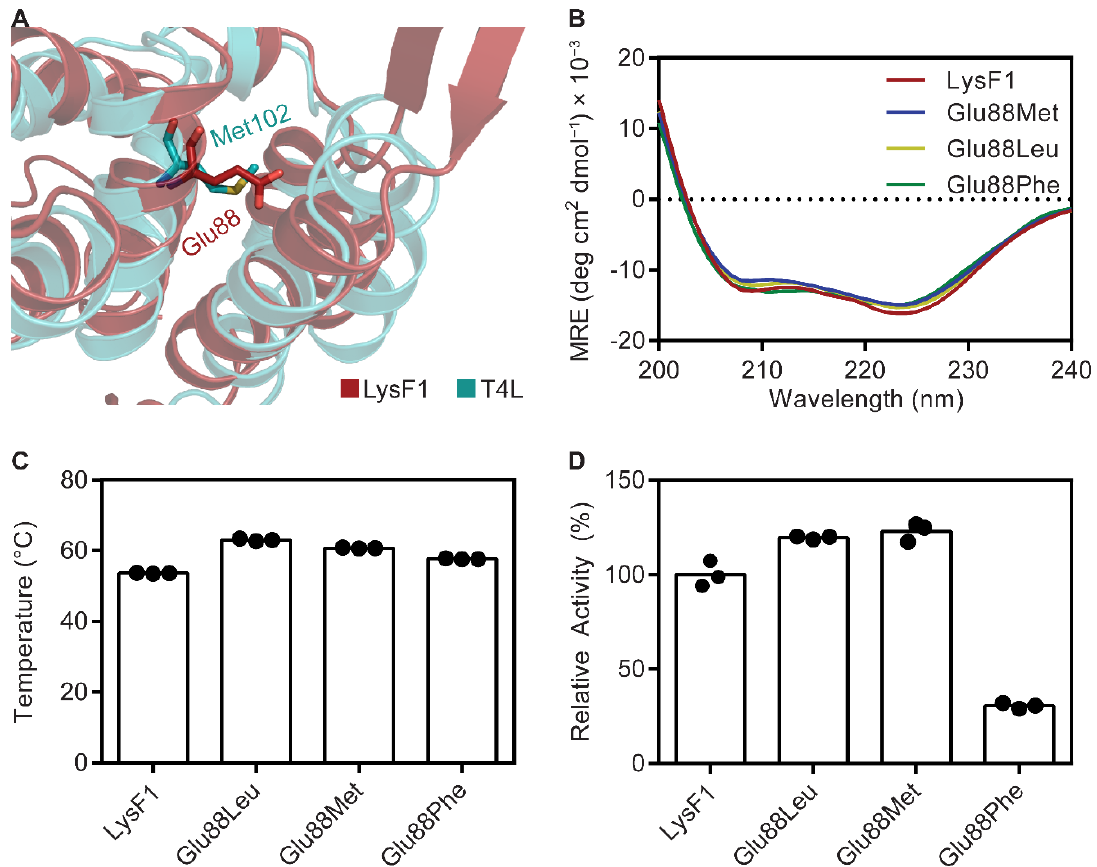
Figure 7. Thermal stability and relative activity of mutants of the charged core. ( A ) A magnified view of the C-terminal α-helix bundle with the crystal structures of LysF1 (red) overlaid with T4L (teal) and the residue of interest, Glu88 of LysF1, is displayed as a stick representation. The similarly positioned residue of T4L, Met102, is shown. ( B ) The circular dichroism spectra of each mutant compared with wild type LysF1. ( C ) The thermal stability of wild type LysF1 and each mutant as measured by differential scanning fluorimetry is shown. ( D ) The muralytic activity of wild type LysF1 as measured in a turbidity reduction assay of outer membrane-permeabilized E. coli cells compared with the three Glu88 mutants, Glu88Leu, Glu88Met and Glu88Phe. Activity is reported relative to wild type activity.